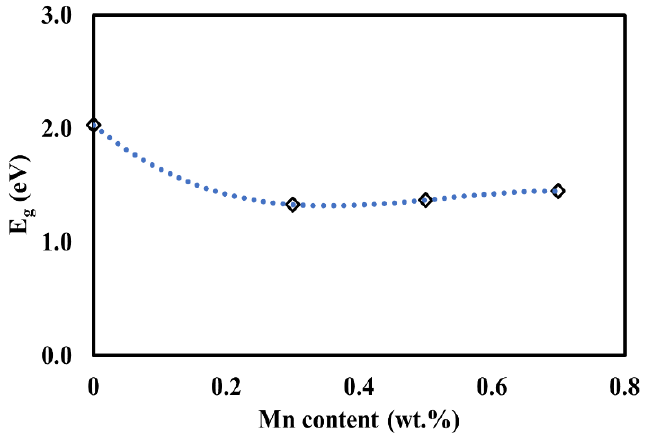
Figure 7. Graph showing the relationship between band gap energies and Mn